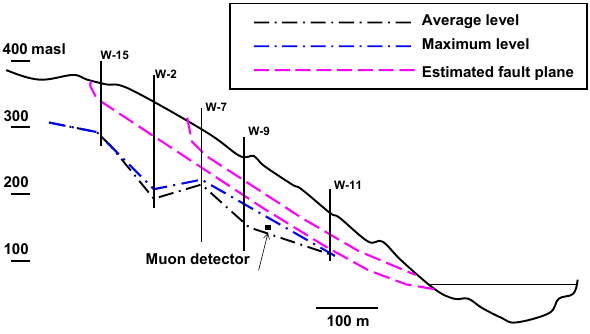
Fig. 3. Cross sectional view of the hill slope. The blue line shows the estimated water table’s head. Two lines show the maximum and av- erage water levels measured in the period between 1999 and 2010. The pink lines show the estimated fault lines. The underground wa- ter levels are measured at W-2, W-7 and W-9